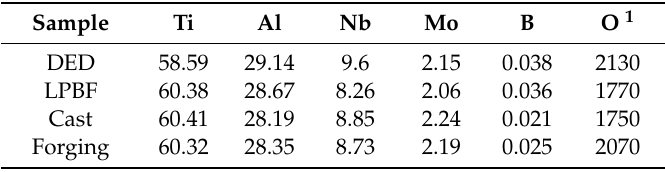
Table 3. Chemical composition of TNM-B1 samples; values in